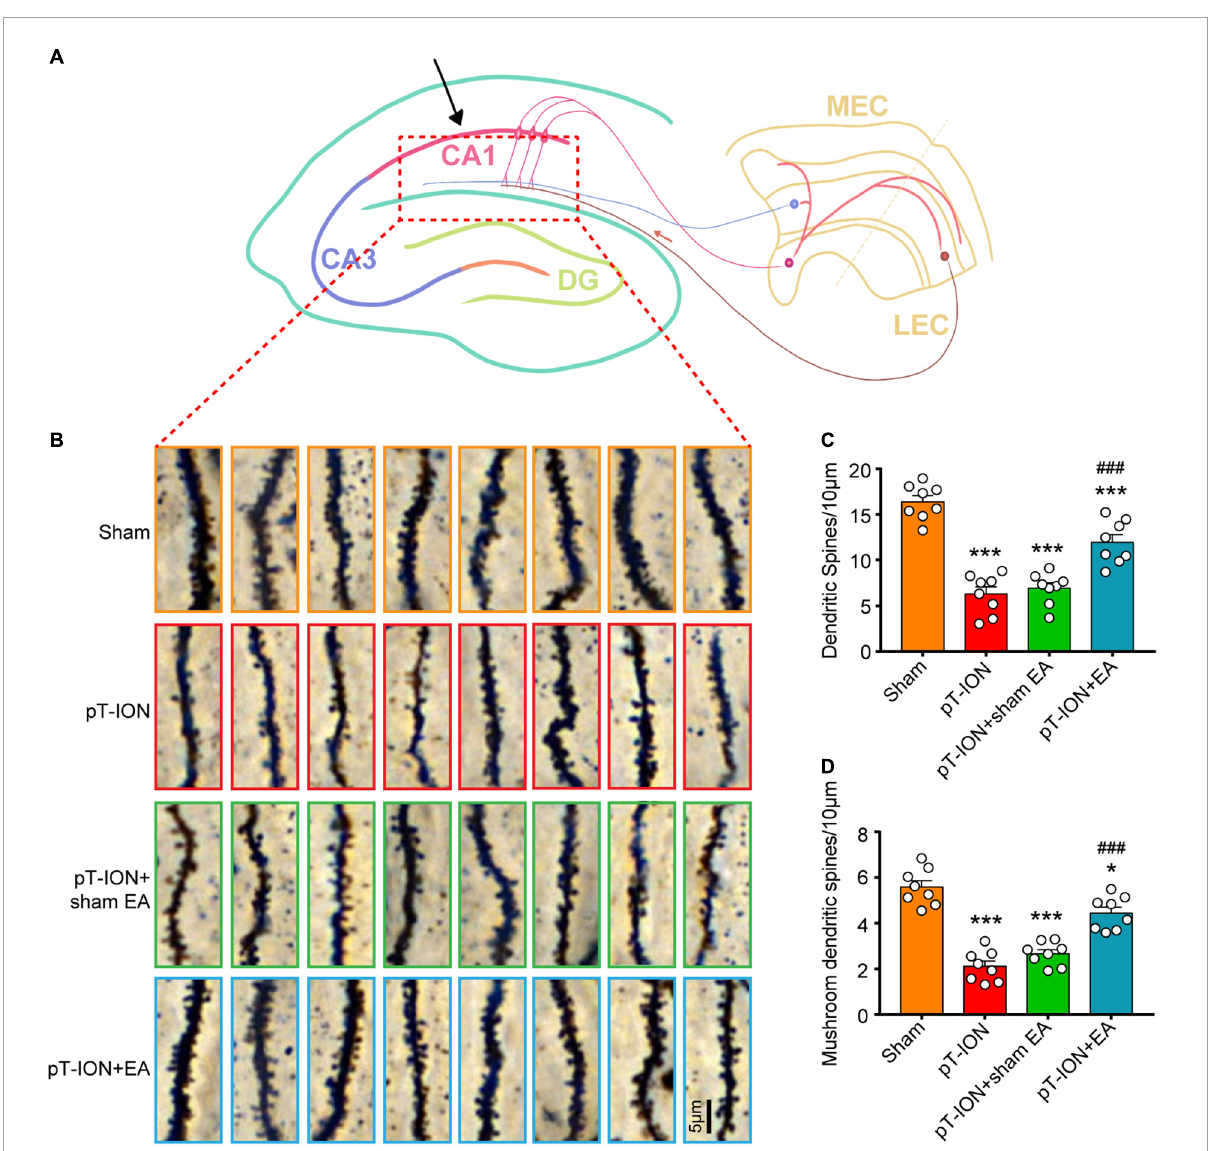
FIGURE5 Electroacupuncture (EA) reverses the decrease in dendritic spine density induced by pT-ION in the CA1 hippocampal region of mouse. (A) Schematic diagram of the hippocampal region of mice. (B) Representative Golgi-Cox-staining images showing the density and morphology of dendritic spines in the cone cell layer of the murine hippocampal CA1 region in each group (scale bar: 5 ◦ µ m). (C) Analysis of total dendritic spine density of the CA1 hippocampal region in each group. (D) Analysis of mushroom-type dendritic spine density in the CA1 hippocampal region in each group. N = 8 mice/group, * P < 0.05 and *** P < 0.001 vs. sham group; ### P < 0.001 vs. pT-ION group, one-way ANOVA and Tukey’s